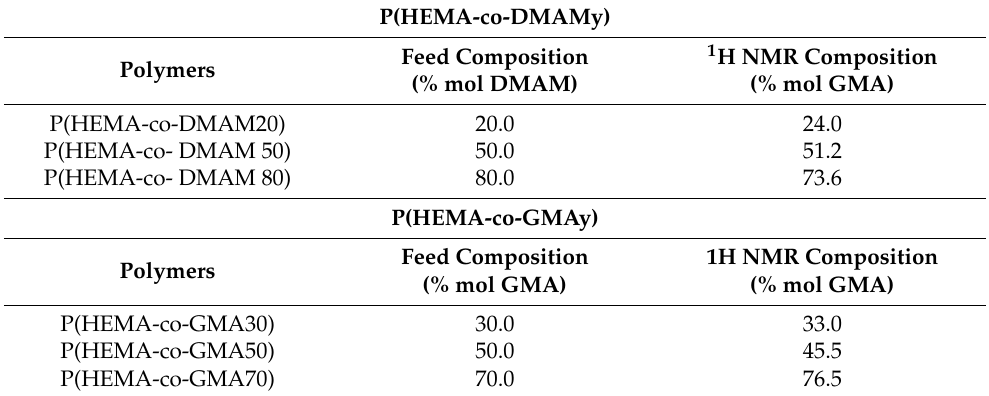
Table 1. Characterization results for the